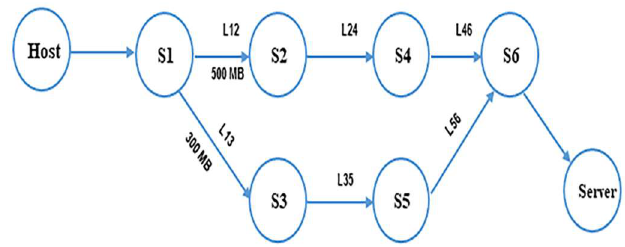
Figure 7. Updating Link